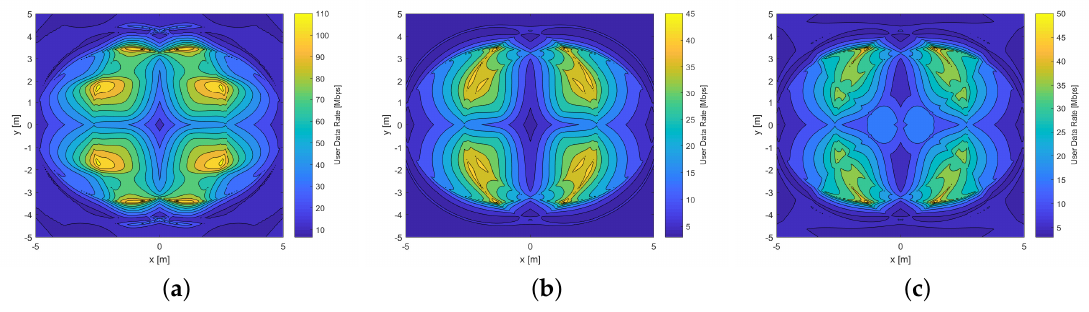
Figure 12. UDR distribution of the pyramidal ADR in the mine working face scenario: ( a ) MRC, ( b ) EGC, and ( c ) SBC